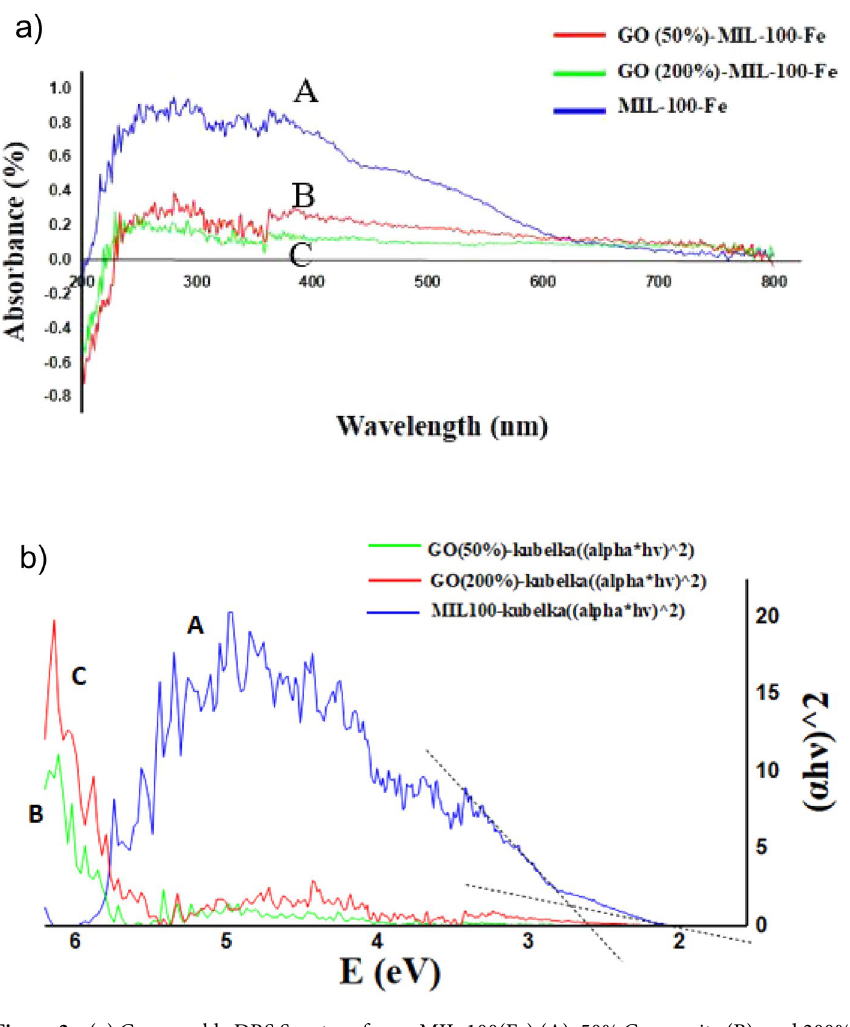
Figure 3. ( a ) Comparable DRS Spectra of pure MIL-100(Fe) (A), 50% Composite (B), and 200% Composite (C). ( b ) Kubelka–Munk plot of pure MIL-100(Fe) (A), 50% Composite (B), and 200% Composite (C).